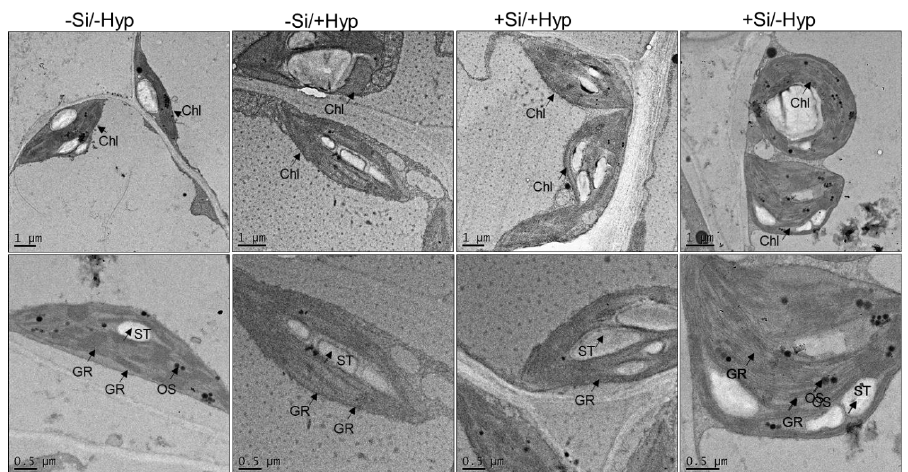
Figure 7. Ultrastructural changes in chloroplasts under hyperhydricity and silicon (Si) treatments (−Si/−Hyperhydricity; −Si/+Hyperhydricity; +Si/+Hyperhydricity; +Si/−Hyperhydricity) in shoot cultures of carnation ( Dianthus caryophyllus L.) grown in vitro . In the figures, Chl denotes chloroplasts, GR denotes grana, ST indicates starch granules, and OS denotes osmium tetroxide.